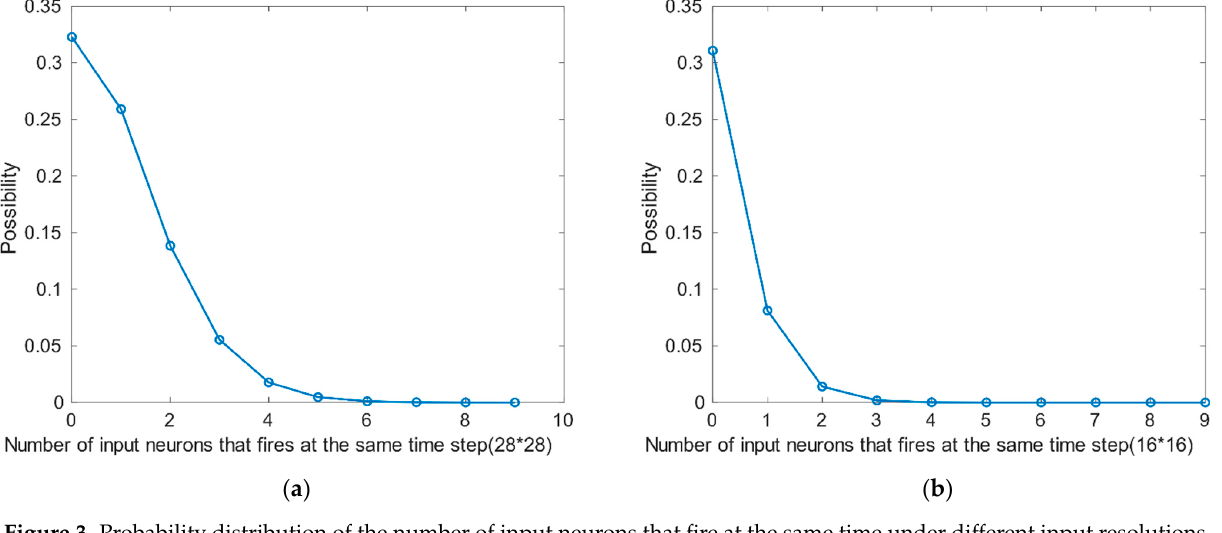
Figure 2. The output spike trains from the Poisson encoders in the first half (0–127) in a time window.